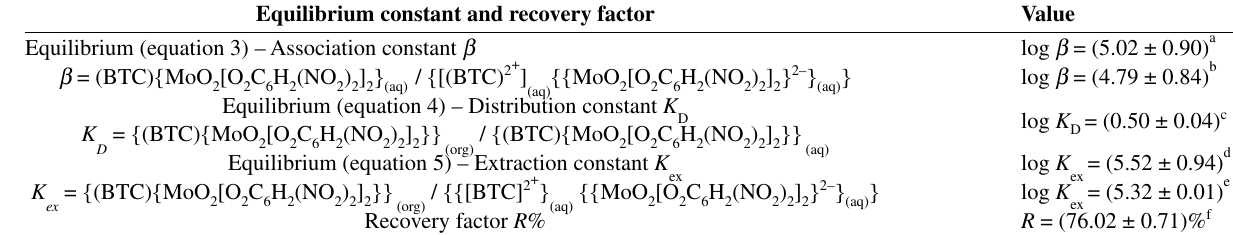
Table 2. Values of the equilibrium constants and the recovery factor Equilibrium constant and recovery factor